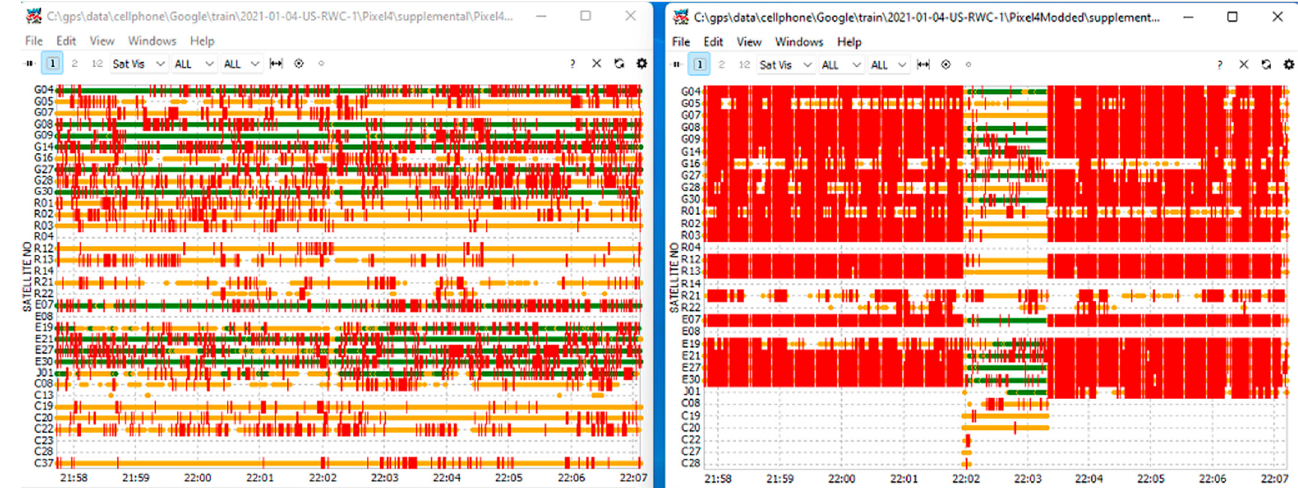
Figure 1. Availability visualization of all satellites present in the observation data for the Pixel 4 and Pixel 4 Modded. The left plot is for Pixel 4, and the right plot is for Pixel 4 Modded. The red markers indicate the flagged potential cycle slips present in the measurements.